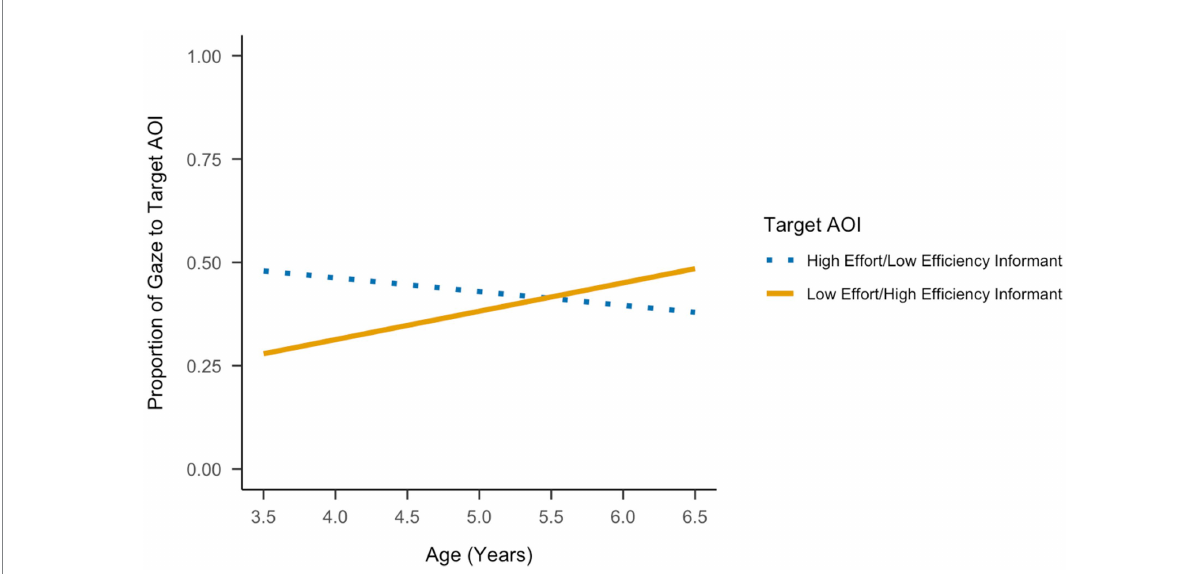
FIGURE 4 Predicted proportion of gaze to the target AOIs during testing as a function of informant (high effort/low efficiency, low effort/high efficiency) and child age.